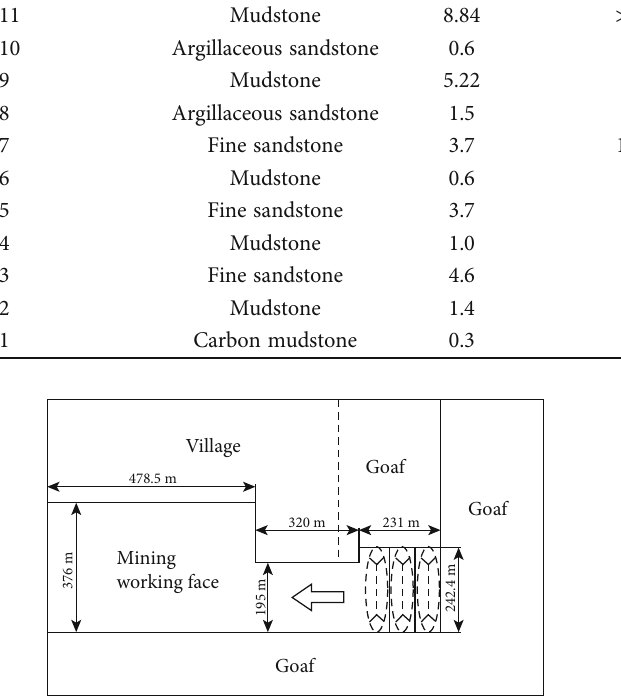
Strati fi cation No.